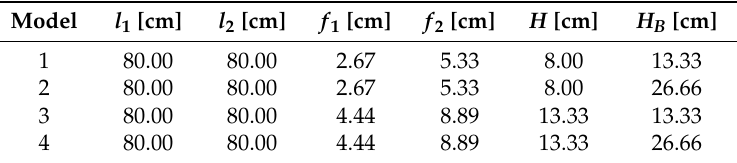
Table 1. Wind tunnel model